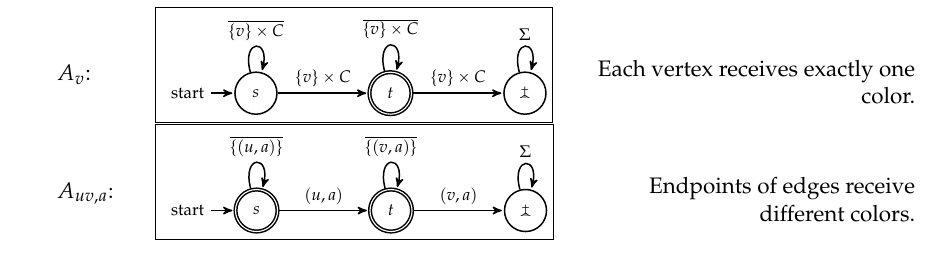
Figure 2. The DFAs necessary to express a proper